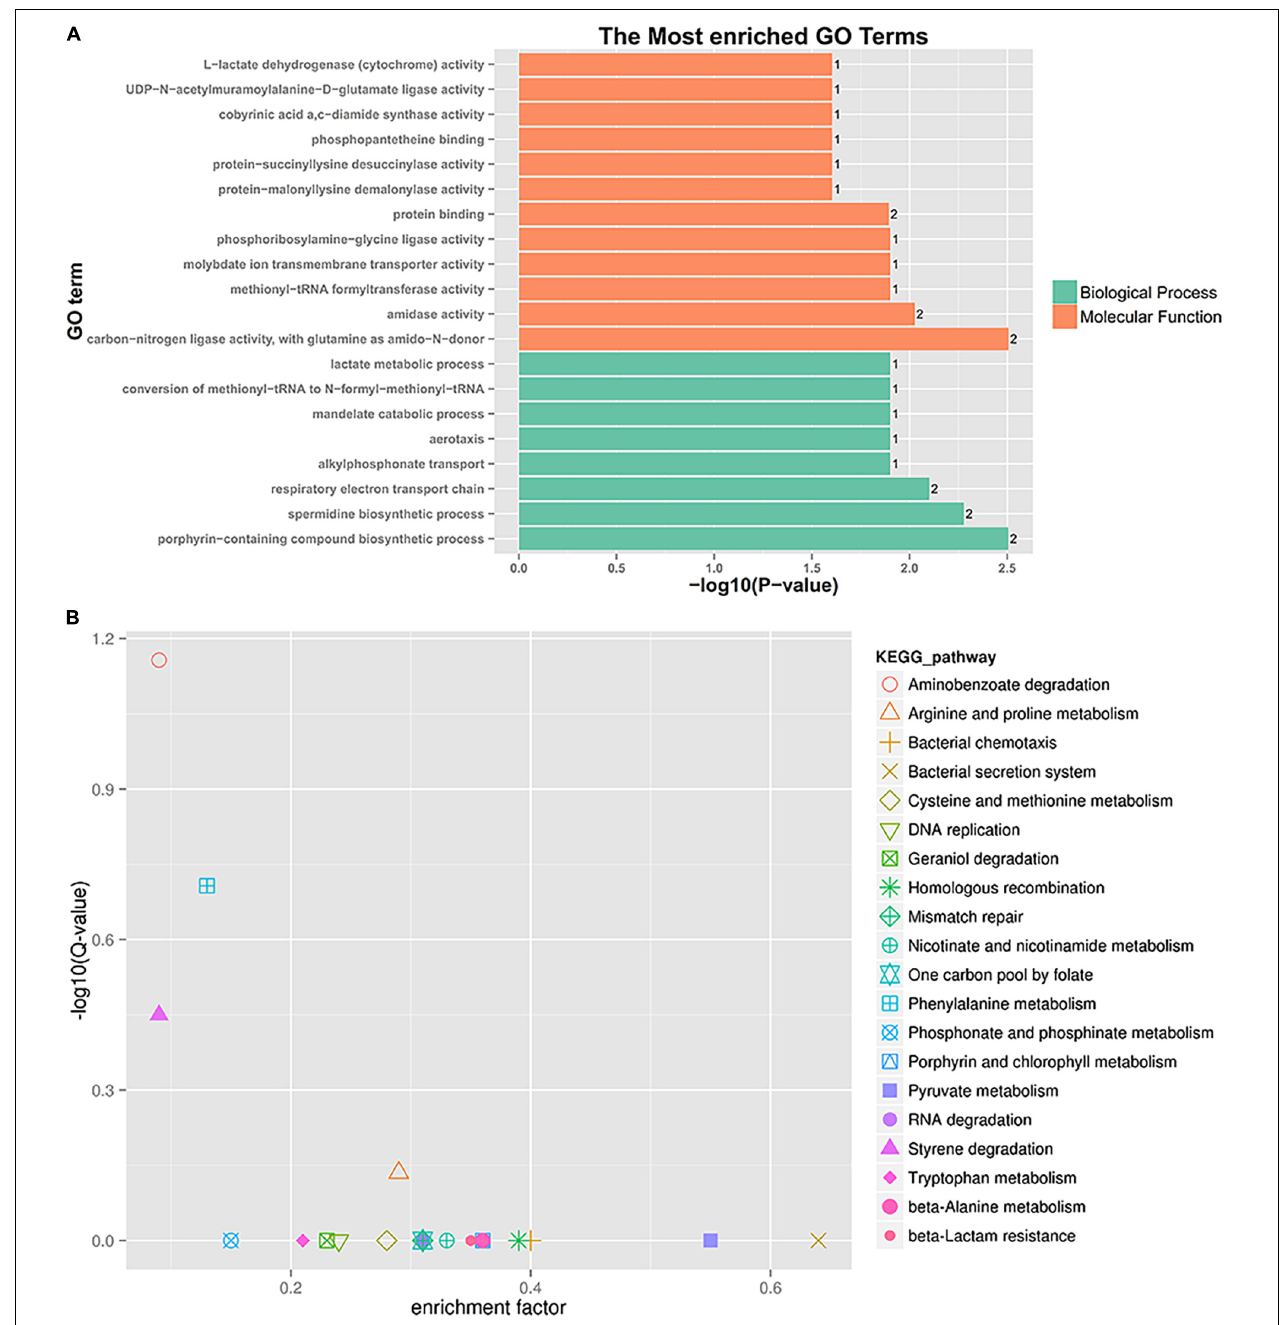
FIGURE 6 | GO enrichment and KEGG pathway analysis of co-expressed sRNA target genes. (A) GO enrichment. (B) KEGG pathway enrichment.